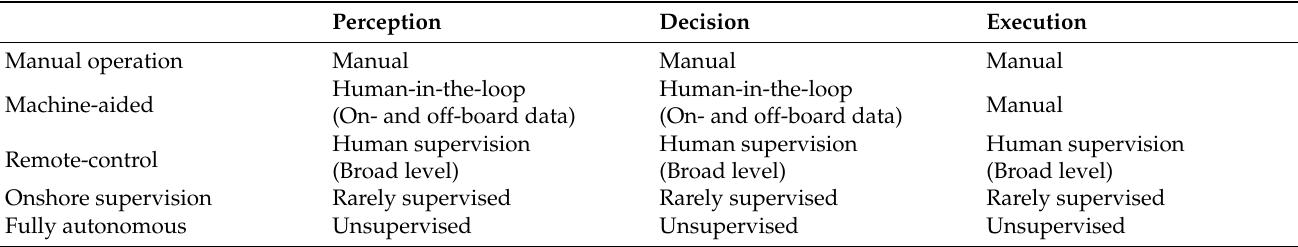
Table 2. Classification of ship